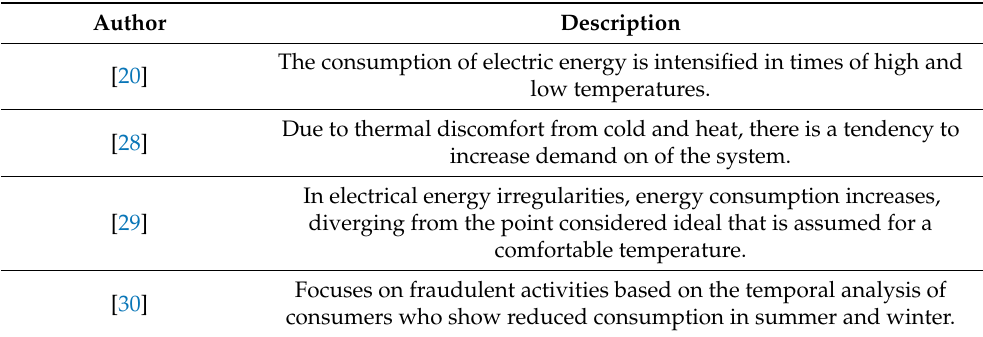
Table 2. Temperature